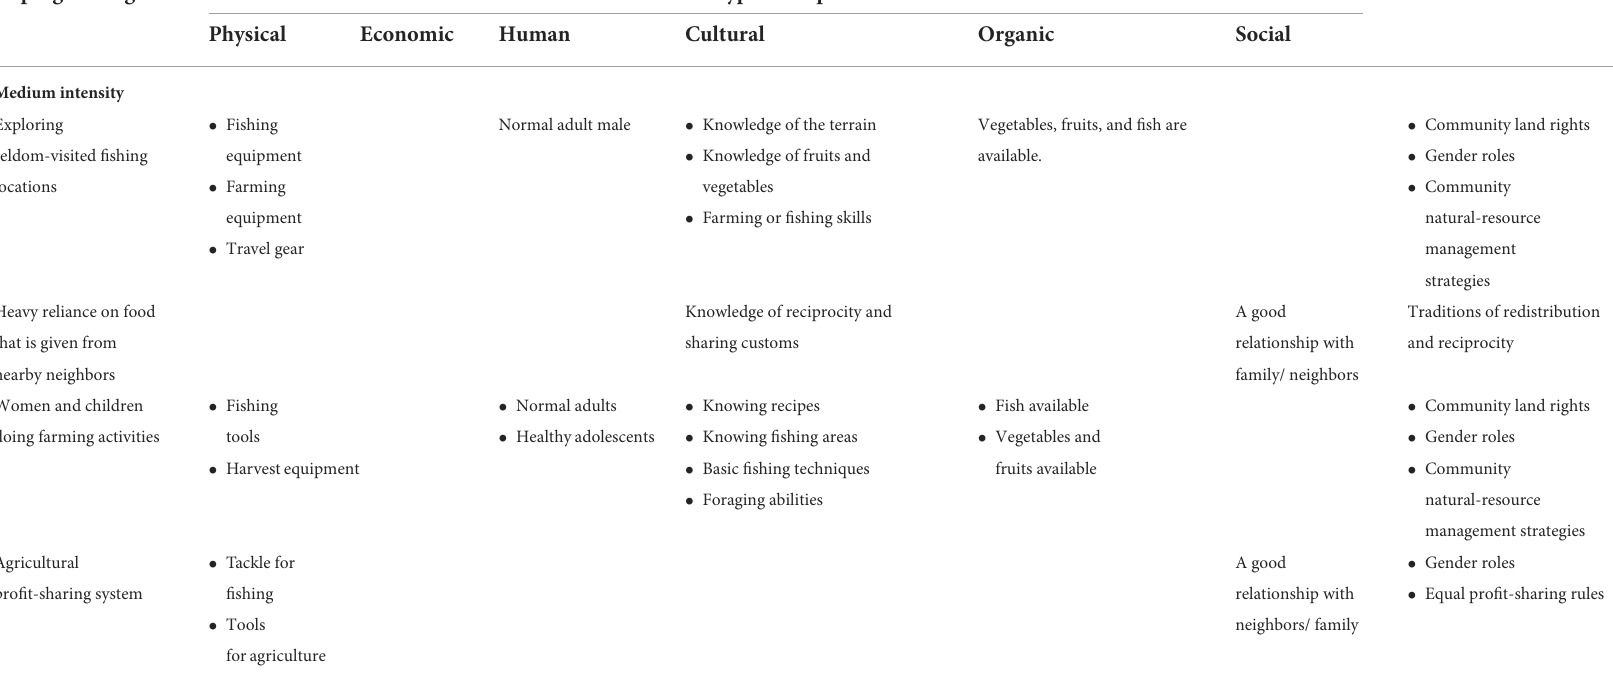
TABLE 5 Addressing food insecurity with medium